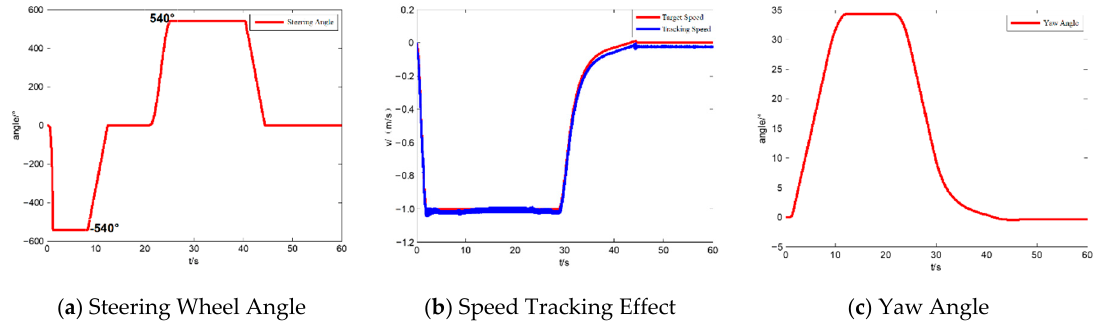
Figure 18. Data Curve of the Experiment Process.